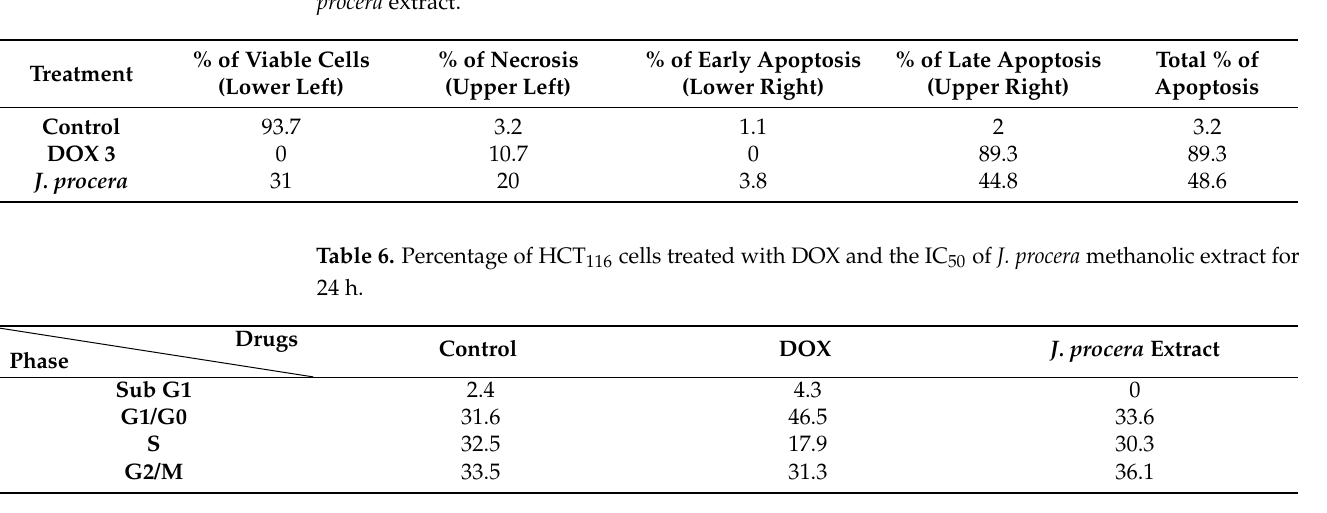
Table 5. Early and late apoptotic percentages in HCT 116 cells treated for 24 h with 3 µ M DOX and J. procera extract.